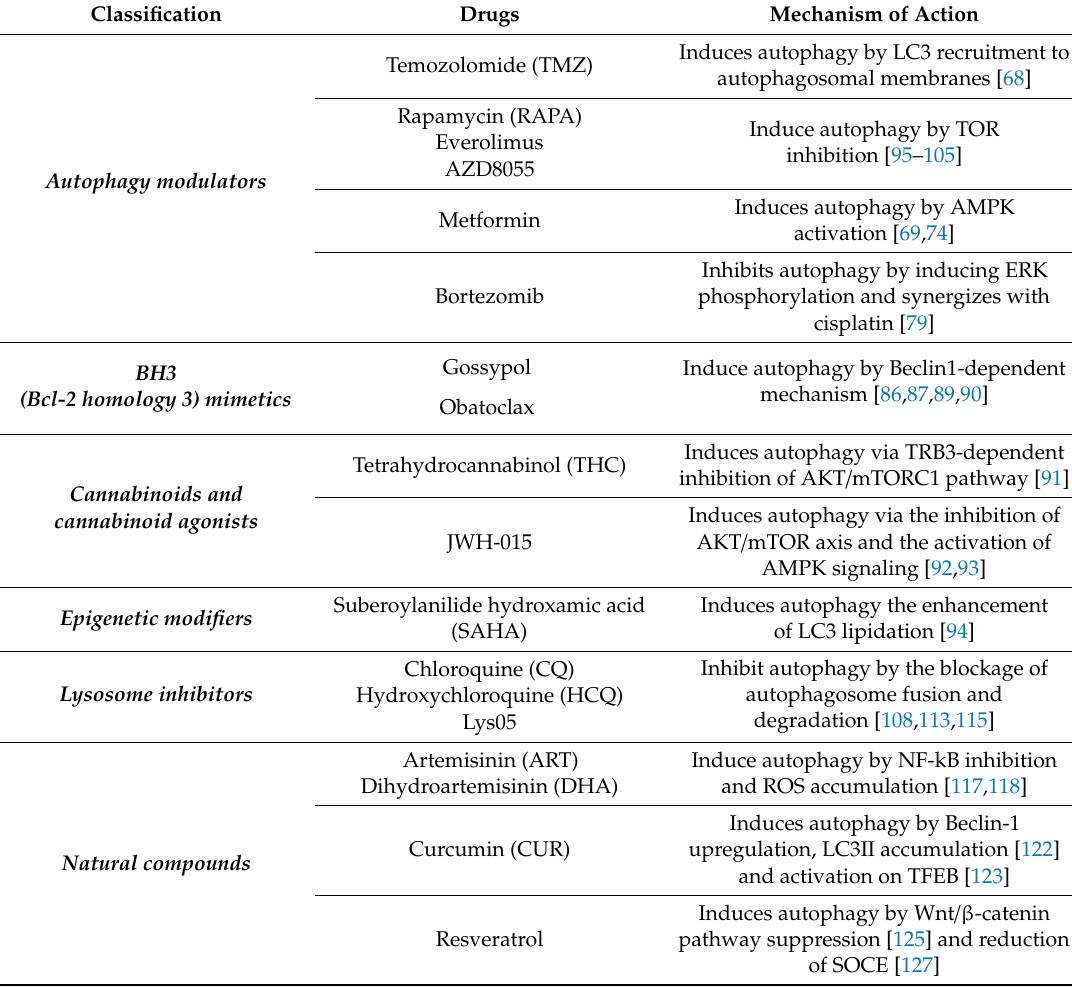
Table 1. Classification of drugs targeting autophagy in cancer